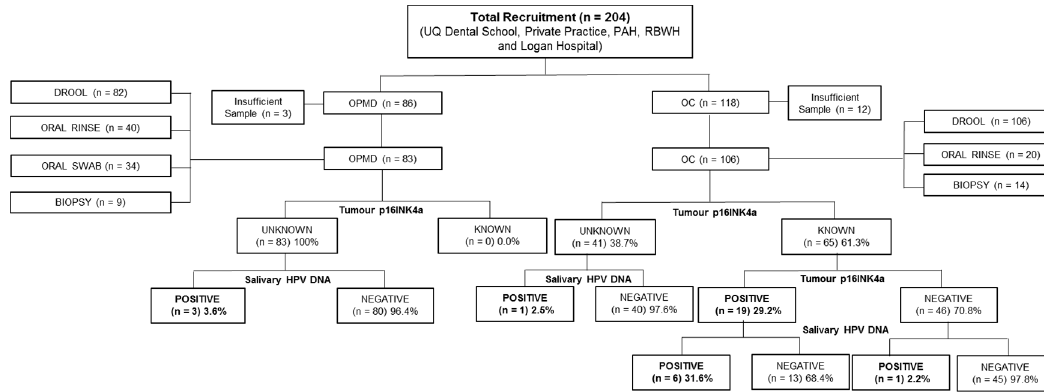
Figure 1. Flow chart of study recruitment.